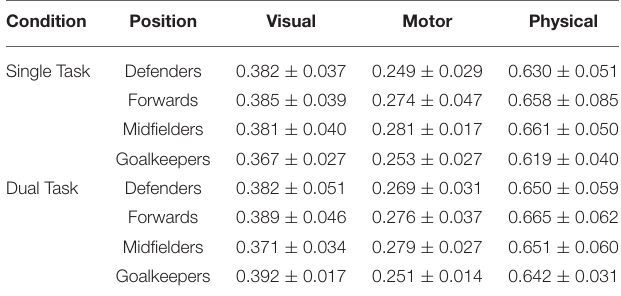
TABLE 2 | Performance during the Reaction Tests